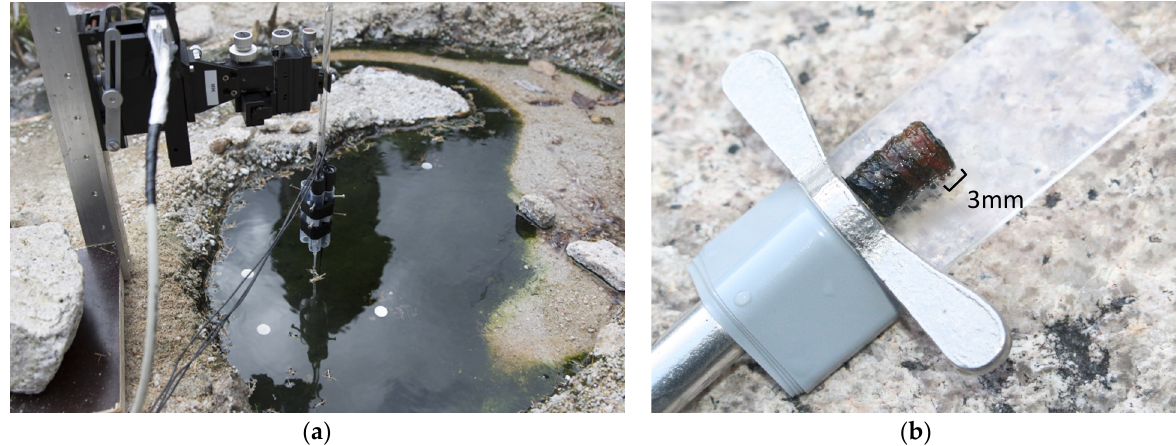
Figure 1. Photographs of the sampling site and cyanobacteria-dominated microbial mat. ( a ) The dark blue-green microbial mats developed at the “Stream Site” of Nakabusa Hot Springs, Japan [19]. ( b ) The microbial mat core samples collected at each time point were 8 mm in diameter and approx. 15 mm thick. The upper 3 mm of the core samples was used in this study.